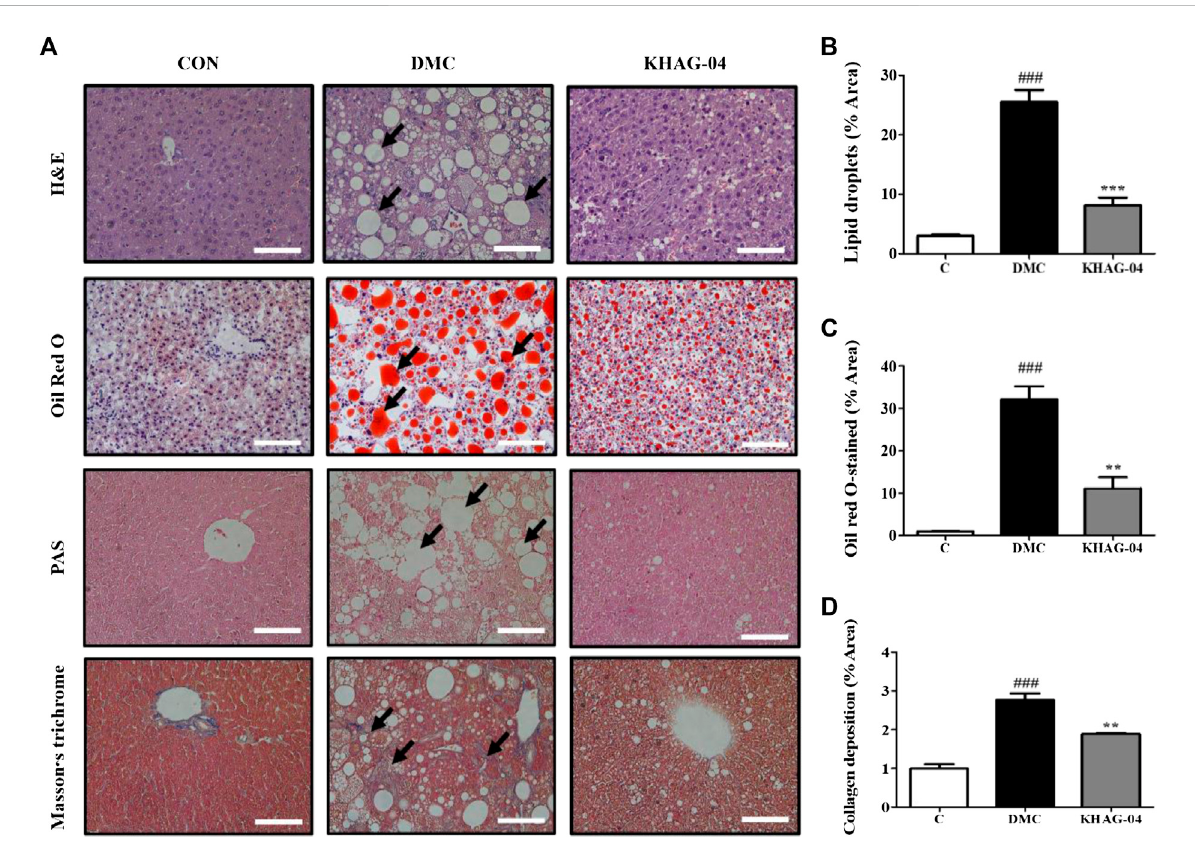
FIGURE 7 Effects of KHAG-04 on hepatic steatosis in the liver of HFD- and STZ-induced T2DM mice. (A) Histological staining of liver sections was performed. Representative H&E, oil red O, PAS, and Masson ’ s trichrome (MT) stained images are shown. Black arrows show lipid droplets and collagen deposition (×100 magni fi cation). The scale bar indicates 100 μ m. Quantitative measurements of lipid droplets (B) , oil red O stained (C) , and collagendeposition (D) valueswerecalculatedusingImageJsoftware.Alldataareindicatedasmean±SEM( ### p < 0.001vsControl;** p <